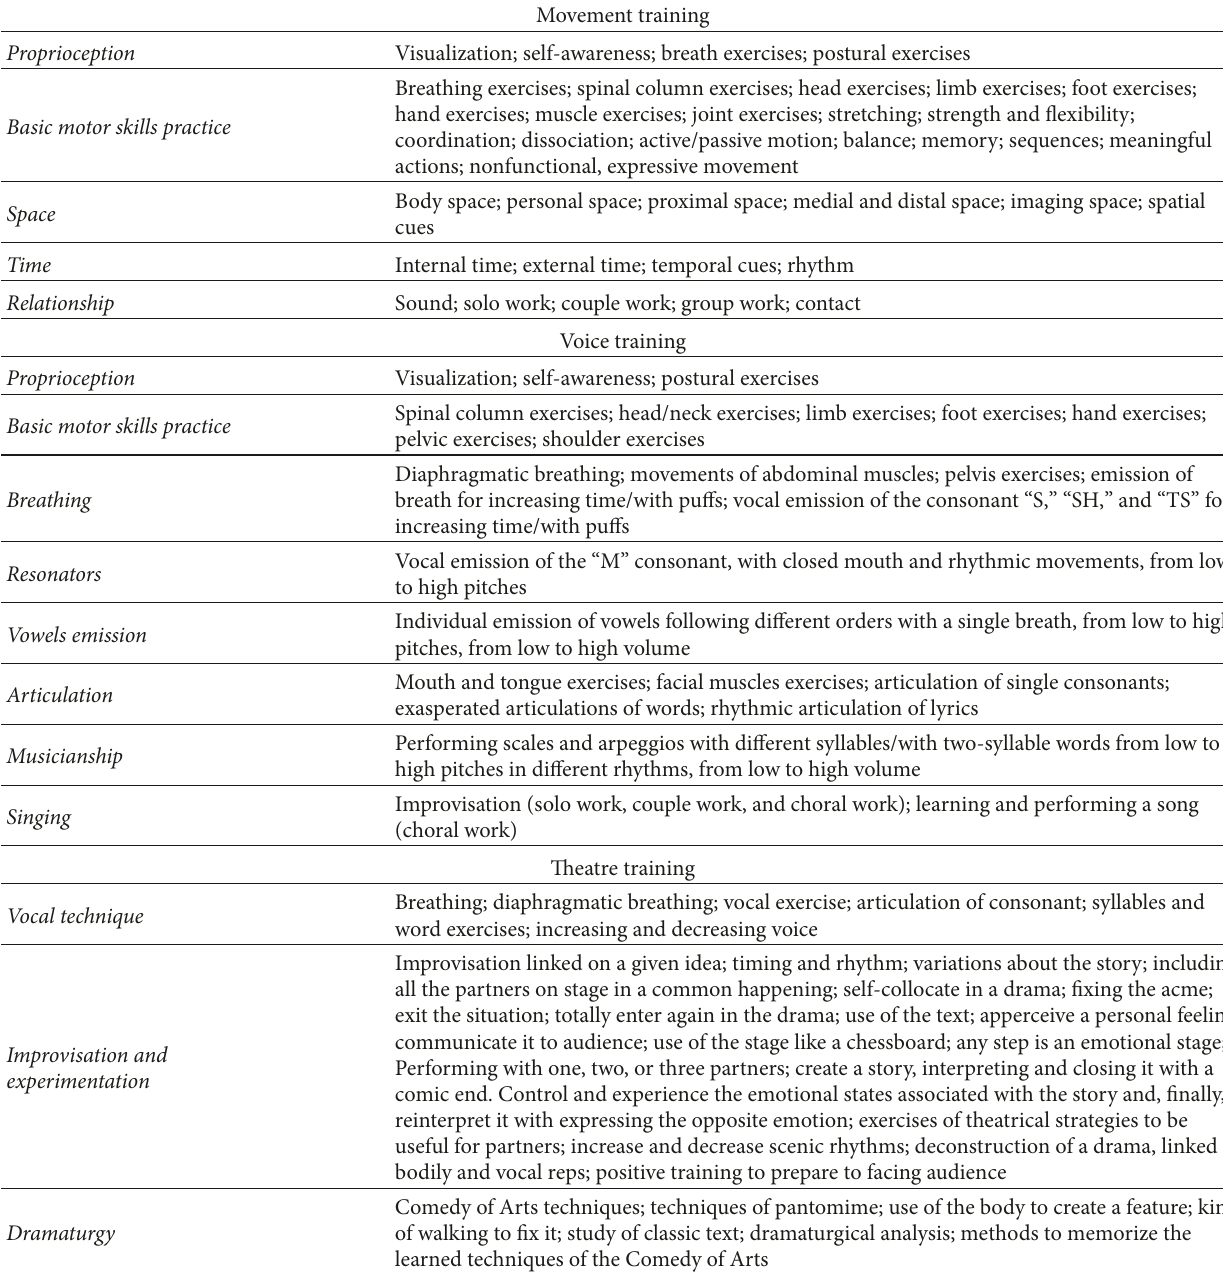
Table 1: Exercises included in a typical emotional theatre training session. It must be remarked that some but not all exercises were performed in each